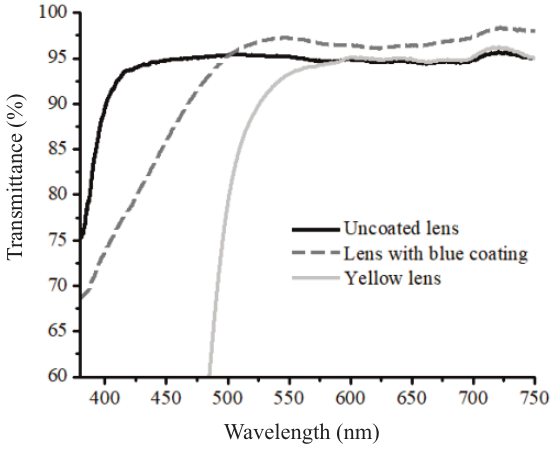
Fig. 2. Spectral transmittances of the clear uncoated lens, the clear lens with a blue-light-filtering coating, and the uncoated yellow